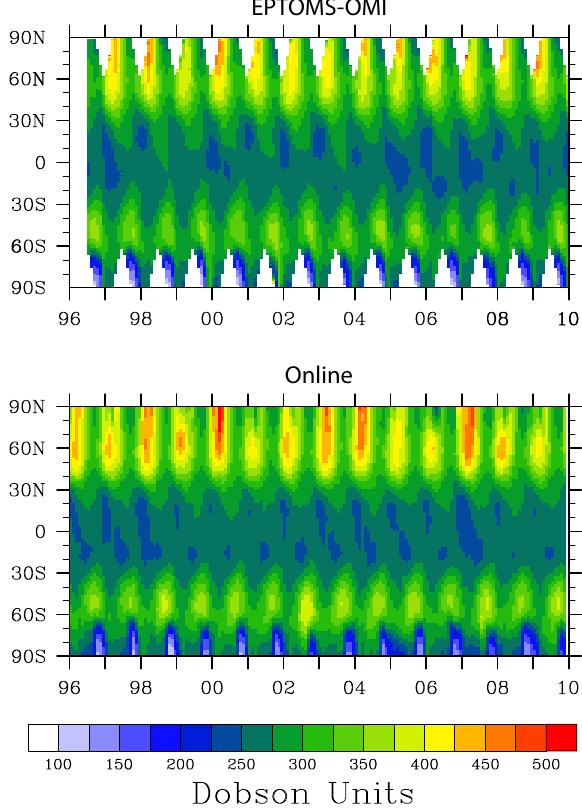
Fig. 14. (a) Timeseries of October total ozone column at 88 ◦ S. (b) Timeseries of March total ozone column at 80 ◦